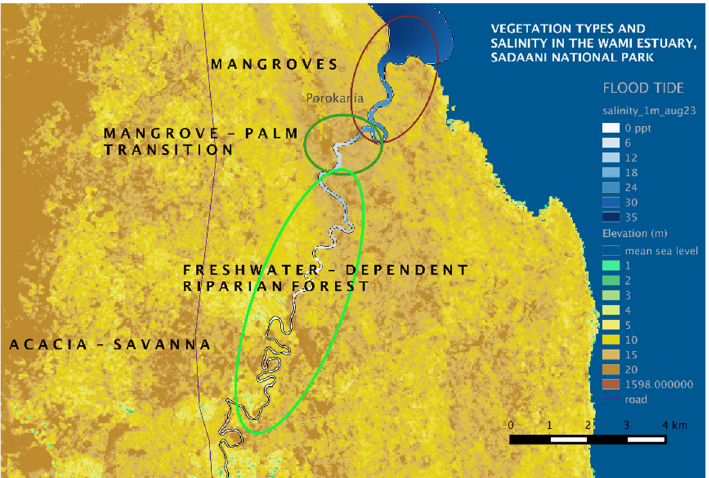
Figure 9. Plant communities in the Wami Estuary, Tanzania, with relation to river salinity; salinity at high tide in August is